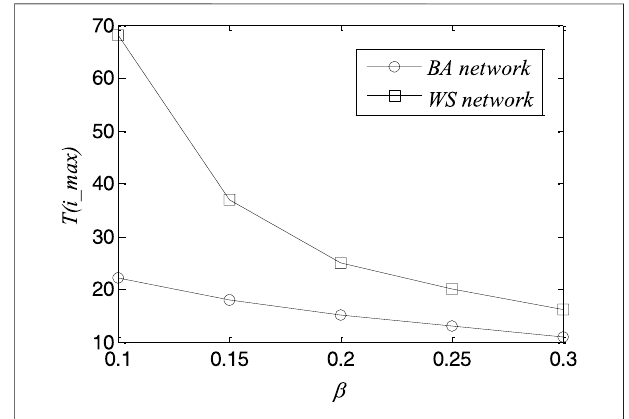
FIGURE 3 | The time of reaching the steady states of the epidemic spread under different infection rates in the Barabási – Albert (BA) and Watts – Strogatz (WS)